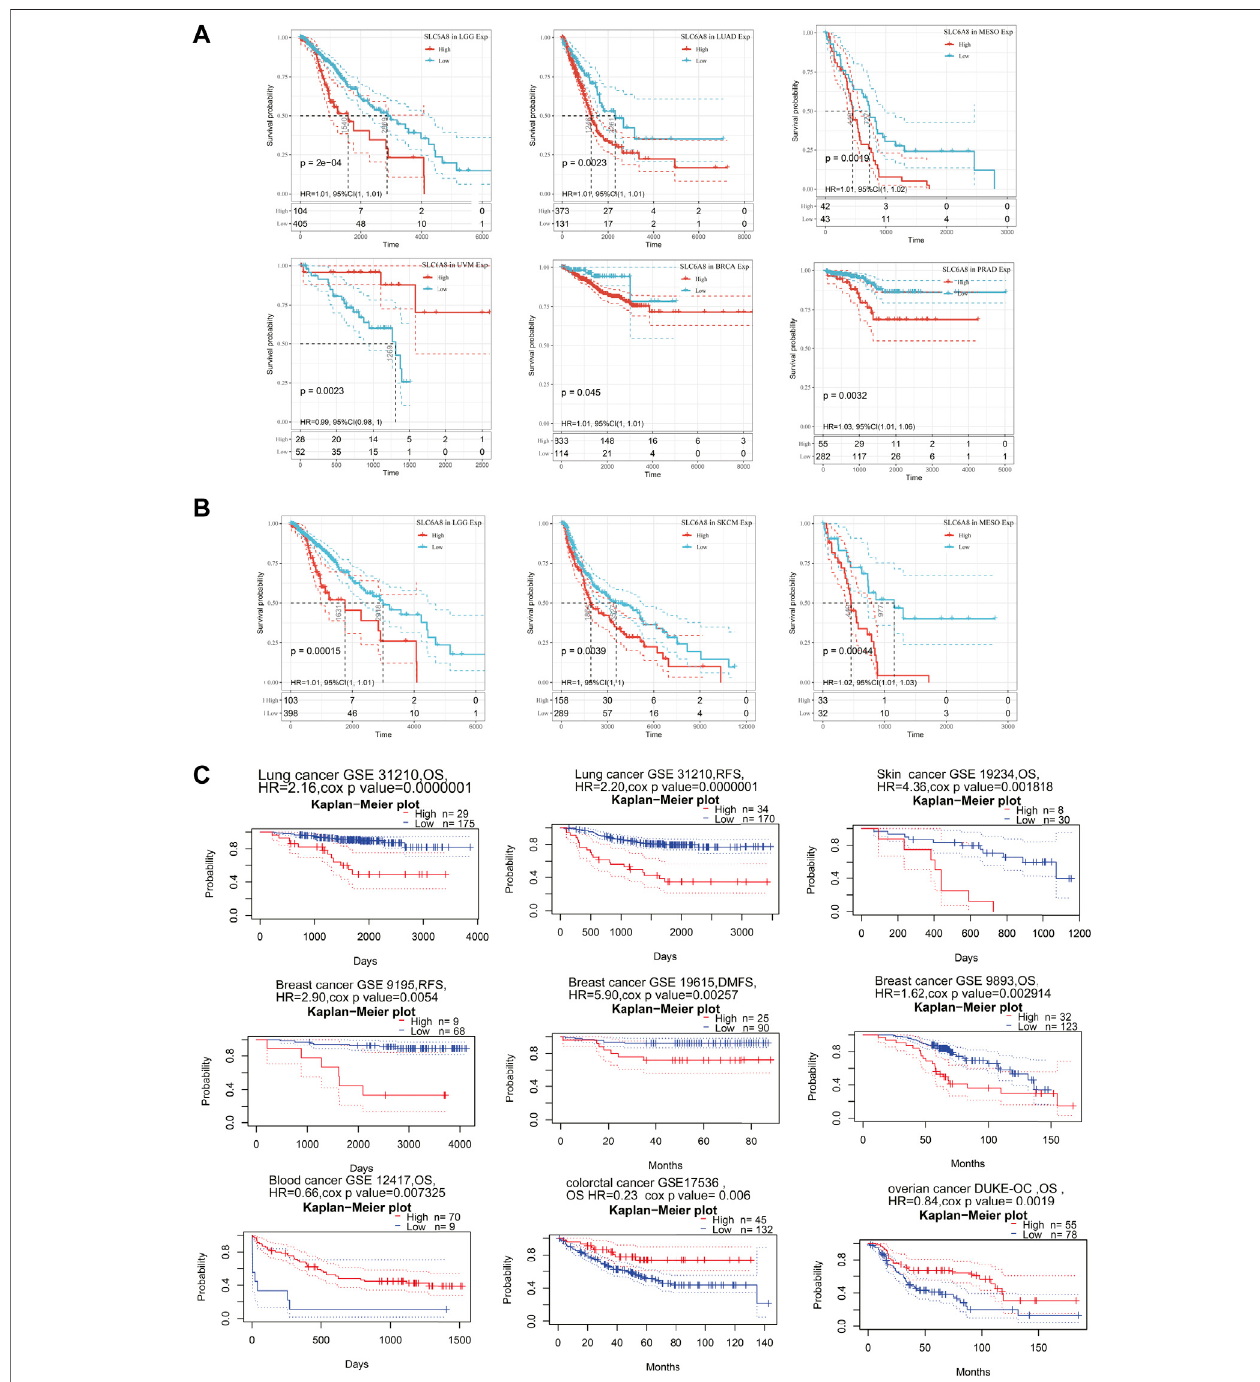
FIGURE 3 | Survival analysis based on SLC6A8 expression in cancers. (A) and (B) Survival curves with signi fi cance of overall survival (A) and disease-free survival (B) based on SLC6A8 expression downloaded from TCGA. (C) Kaplan – Meier plots according to prognoscan database. * p < 0.05, ** p < 0.01, *** p < 0.001.